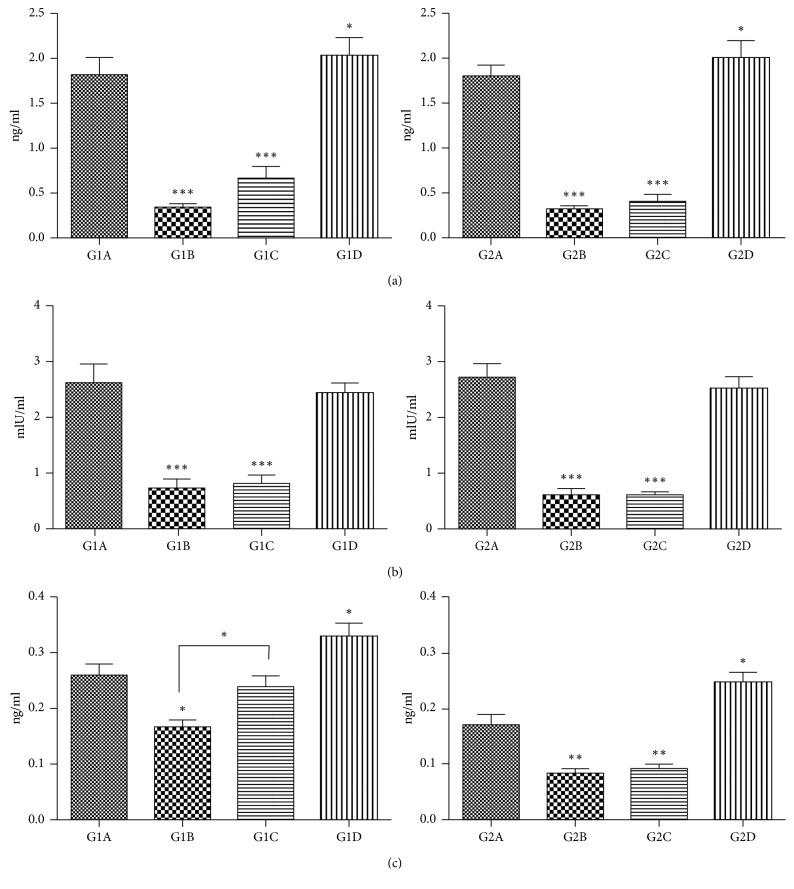
Statistical evaluation of serum testosterone (a), LH (b), and ucOC (c) levels in Group 1 and Group 2 subjects. ∗∗∗p < 0.0001; ∗∗p < 0.001; ∗p < 0.01.